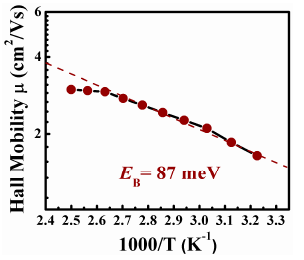
Figure 5. The Hall mobility as a function of the reciprocal temperature for the un-doped nc-Si film.